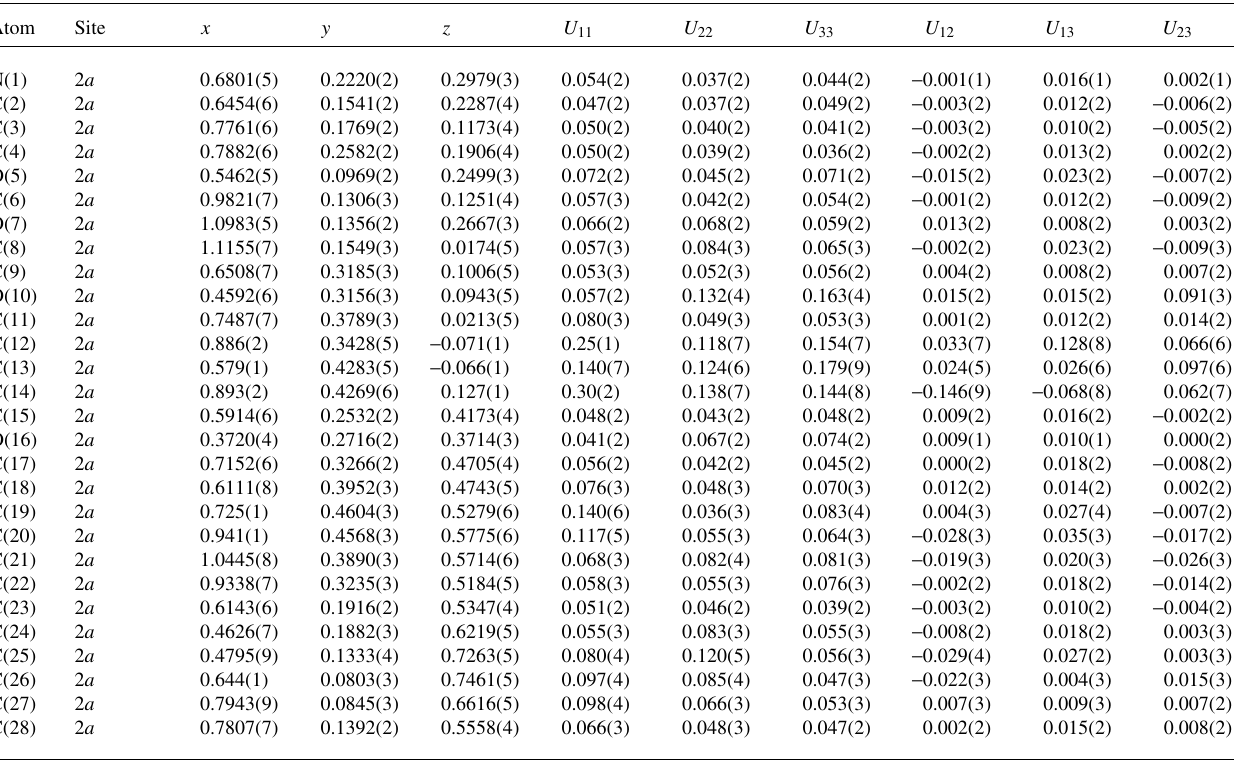
Table 3. Atomic coordinates and displacement parameters (in Å 2 ) .